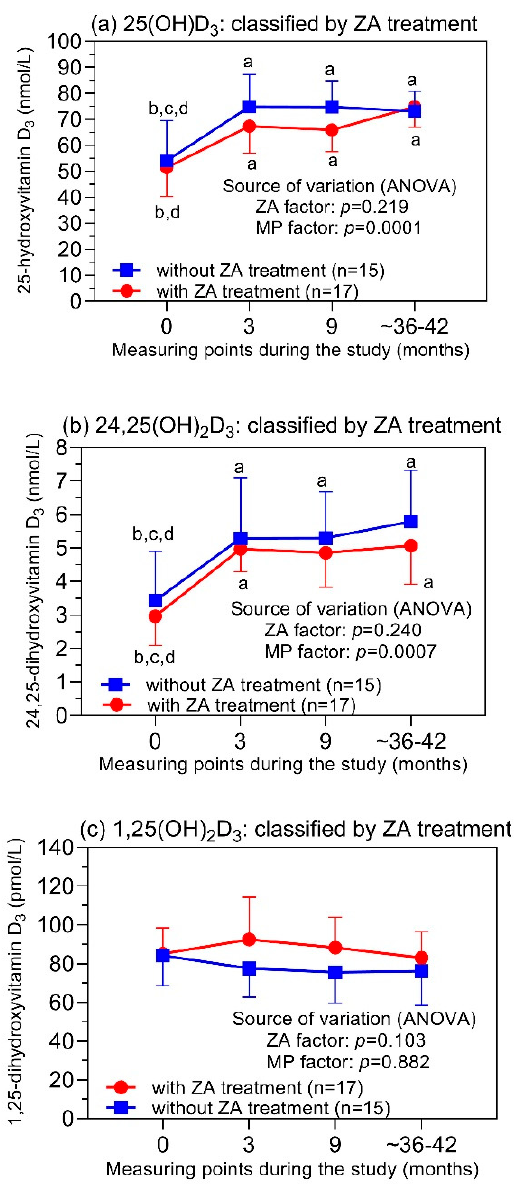
Figure 3. Levels of ( a ) 25(OH)D 3 , ( b ) 24,25(OH) 2 D 3 , and ( c ) 1,25(OH) 2 D 3 before and during the ZA treatment at different time intervals of the study. Repeated measures were performed before the treatment (time point = 0) and 3 and 9 months after the treatment start. The last measuring points were 36 and 42 months (mean values) for patients without and with ZA treatment, respectively. Results of the repeated-measures two-factor ANOVA classified according to the factor ZA treatment (without ZA, n = 15; with ZA, n = 17) are shown as mean values with their 95% confidence intervals. At the error bars, the letters a, b, c, and d indicate statistically significant differences in the vitamin D 3 levels between the different measuring points (at least p < 0.05; corrected values according to Holm–Sidak test): a, compared to “before study”; b, compared to 3 months; c, compared to 9 months; d, compared to ~36–42 months. No statistically significant differences for all three metabolite levels were found between the two ZA groups at the respective measuring points. Abbreviations: ANOVA = analysis of variance; ZA = zoledronic acid; MP factor = related to the time intervals of the measuring